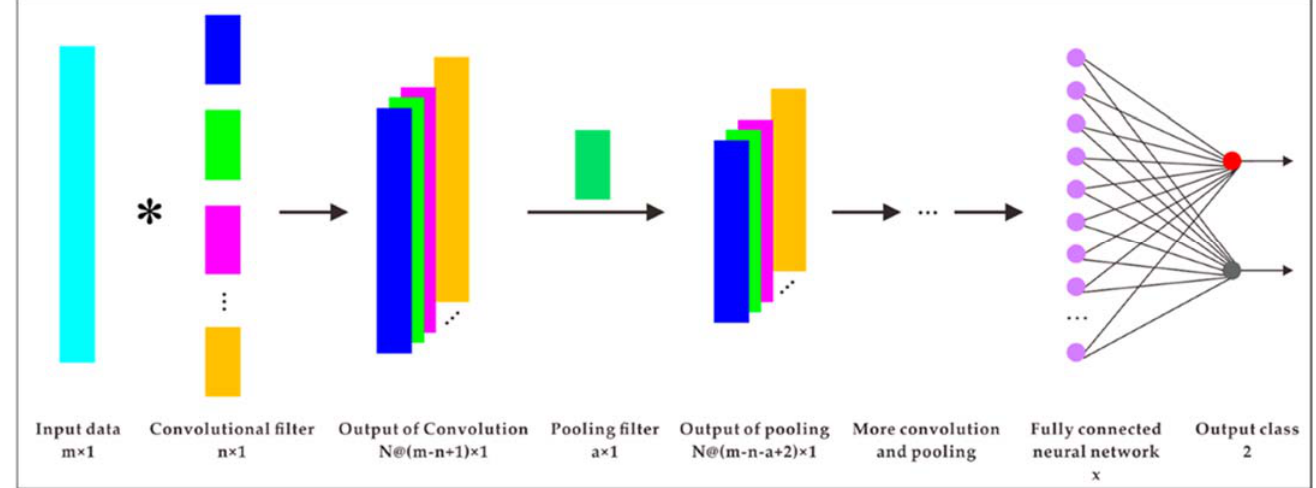
Figure 6. Convolutional Neural Network workflow [152].